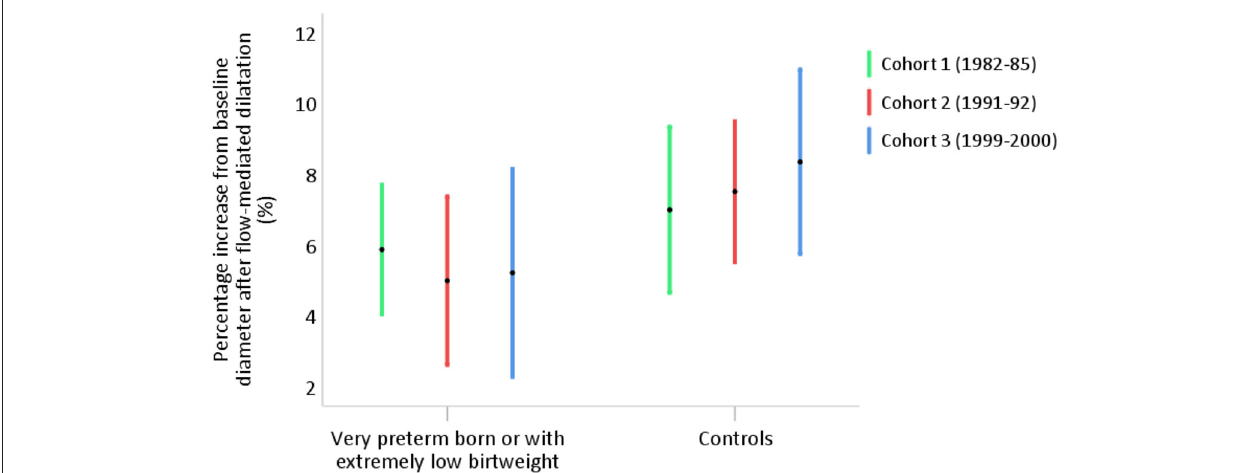
FIGURE 6 | Percentage flow-mediated dilatation of the brachial artery in young adults born very preterm or with extremely low birthweight (PB/ELBW) born in year 1982–1985 (cohort 1, n = 21), 1991–1992 (cohort 2, n = 16), and 1999–2000 (cohort 3, n = 13), presented as mean with 95% CI. Percentage FMD was 5.8% (95%